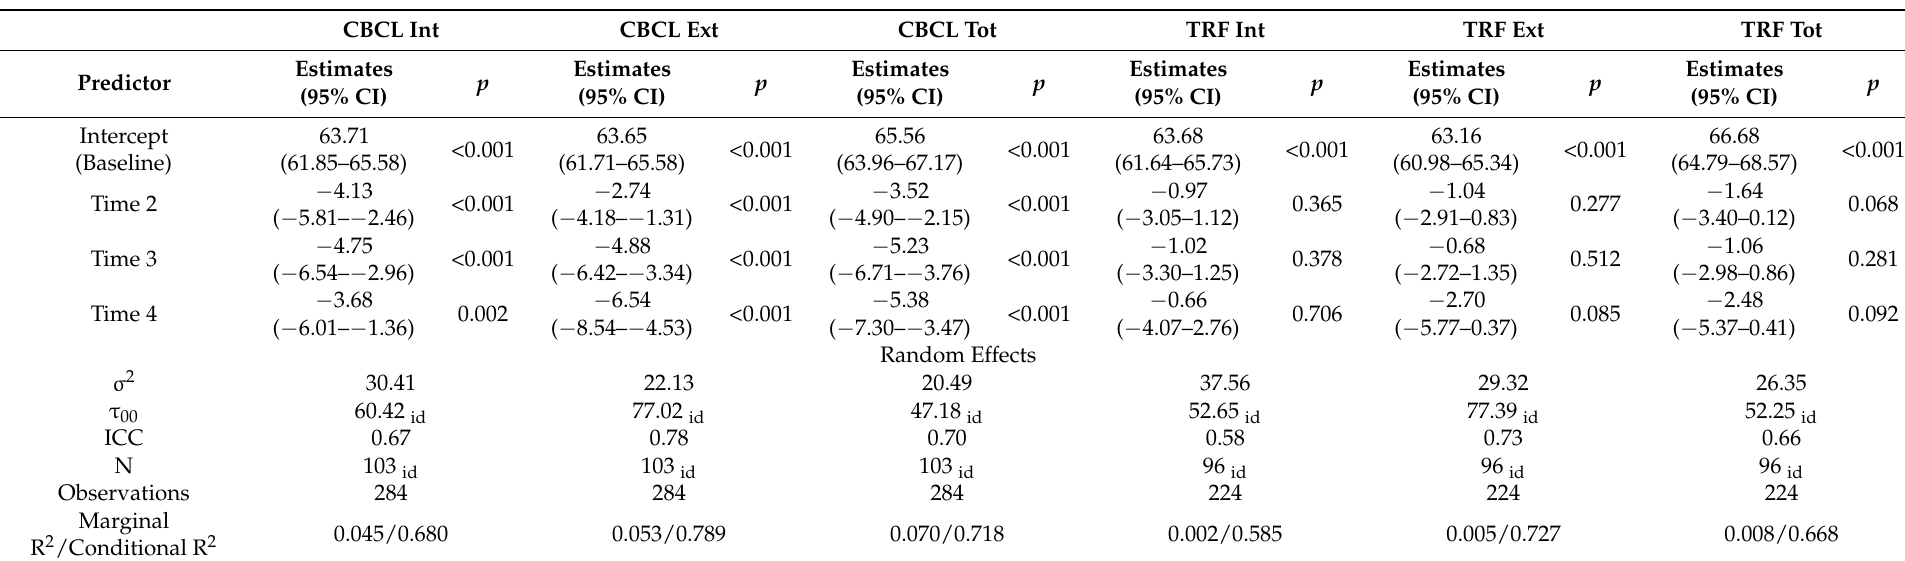
Table 3. CBCL and TRF score changes over time from baseline to Time 2, Time 3, and to Time